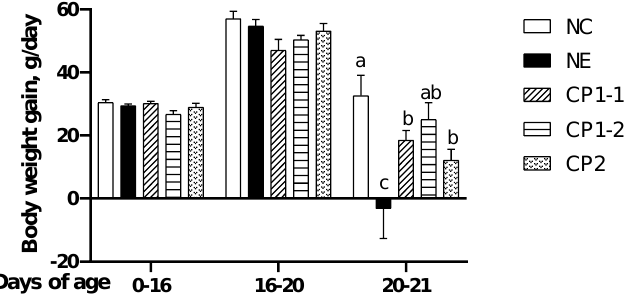
Figure 3. CP-spor-super vaccines protected birds against NE-induced body weight gain loss. Cohorts of 7–16 birds were fed basal diet and immunized with various CP-spor-super vaccines at d 0 and 10. To induce necrotic enteritis (NE), the birds were infected with 20,000 oocysts/bird E. maxima at 16 days of age and then infected with 10 9 CFU/bird C. perfringens at 20 days of age. The birds were sacrificed at 21 days of age. The daily body weight gain during noninfected phase of d 0–16, E. maxima phase of d 16–20, and NE phase of d 20–21 are shown. All graphs depict mean ± SEM. Different letters of a, b, and c mean p < 0.05. Results are representative of two independent experiments.